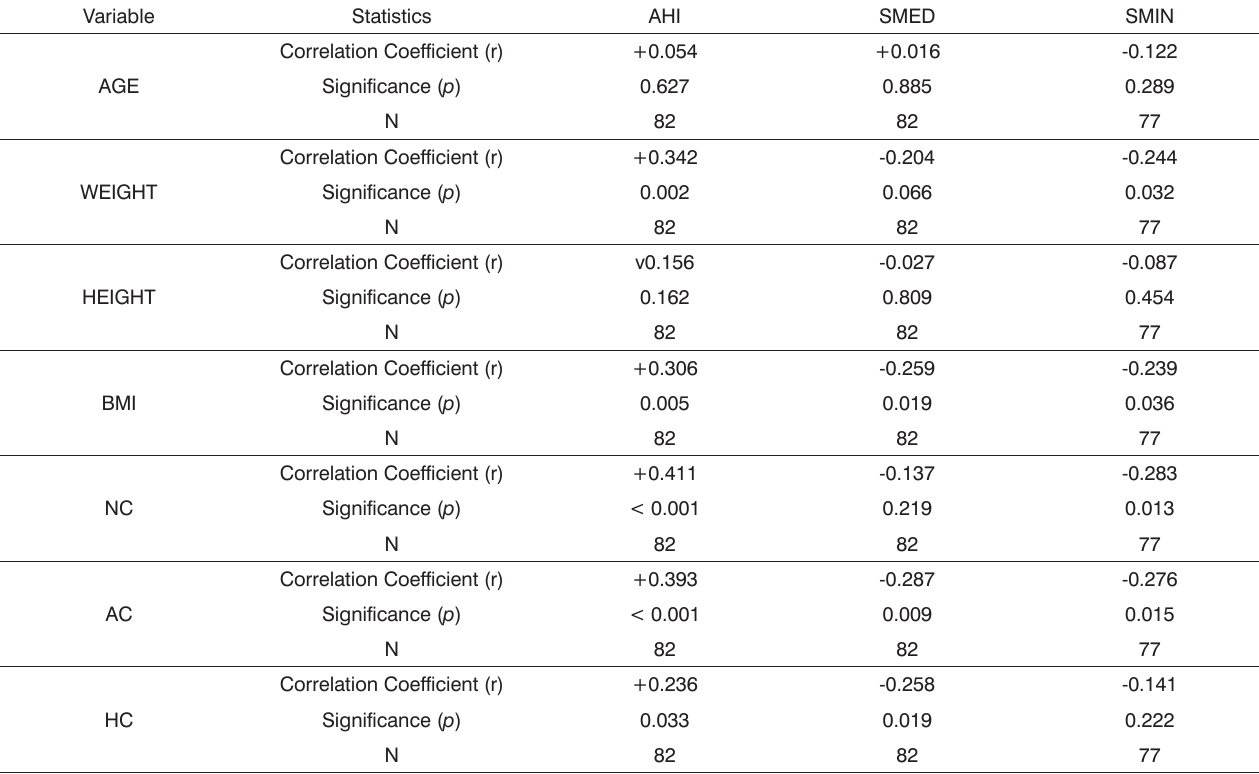
Table 2. Correlation of anthropometric measurements with OSAHS